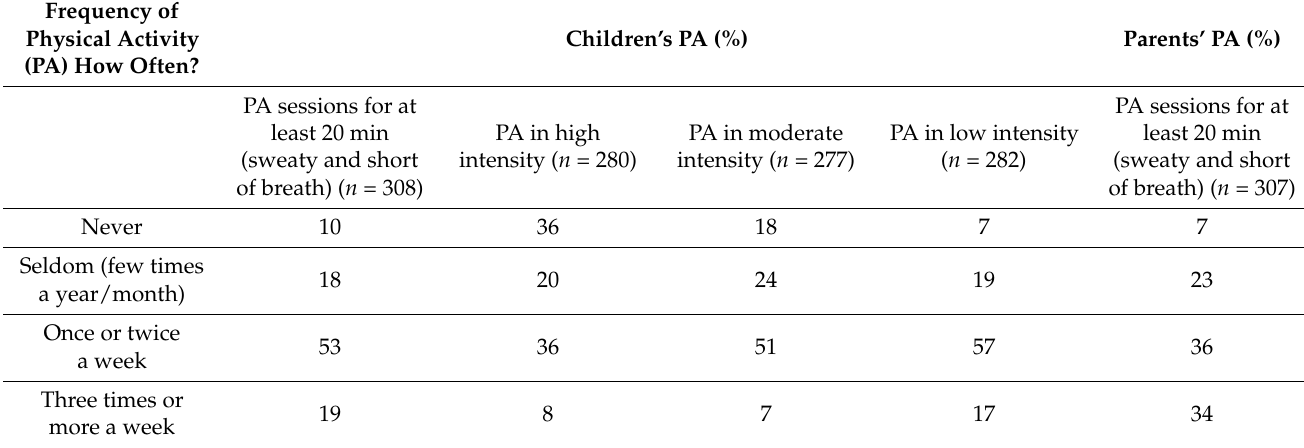
Table 3. Frequency of physical activity (PA) sessions for at least half an hour sessions to get sweaty and short of breath among children with Down Syndrome (DS) and among parents. Frequency of PA in high, moderate and low intensity for at least 20 min sessions among children with DS